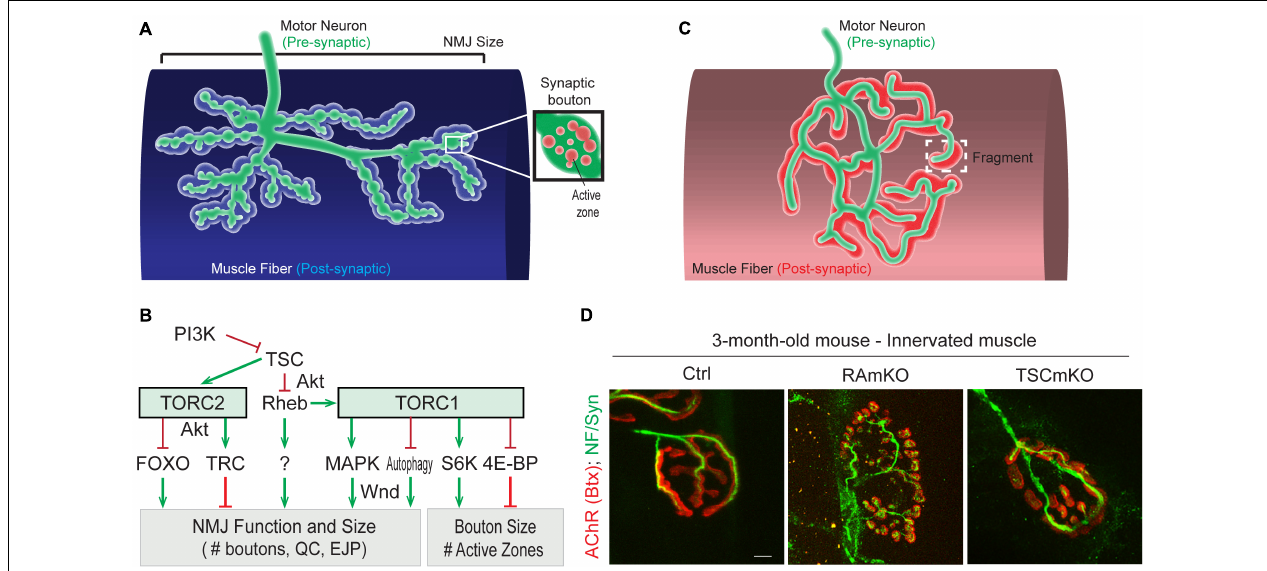
FIGURE 3 | Role of (m)TORC1 signaling in NMJ maintenance. (A) NMJ organization in Drosophila, showing the synaptic boutons spreading on the muscle fiber. (B) TORC1 and TORC2 signaling regulate the size of the NMJ (number of synaptic boutons), via the MAPK pathway, the autophagy process, FOXOs and the kinase Trc. TORC1 also controls the size of the synaptic boutons, via S6K and 4E-BP1. (C,D) Typical pretzel-shape structure of rodent NMJ (up), with the pre-synaptic compartment (motor axon) shown in green and the post-synaptic region in red. Deregulation of mTORC1 in muscle leads to NMJ alterations, with an increased fragmentation of the motor endplate (D). Motor axon is stained with Neurofilament and Synaptotagmin (green); AChRs at the muscle membrane are labeled with fluorescent bungarotoxin (red). Scale bar, 10 µ